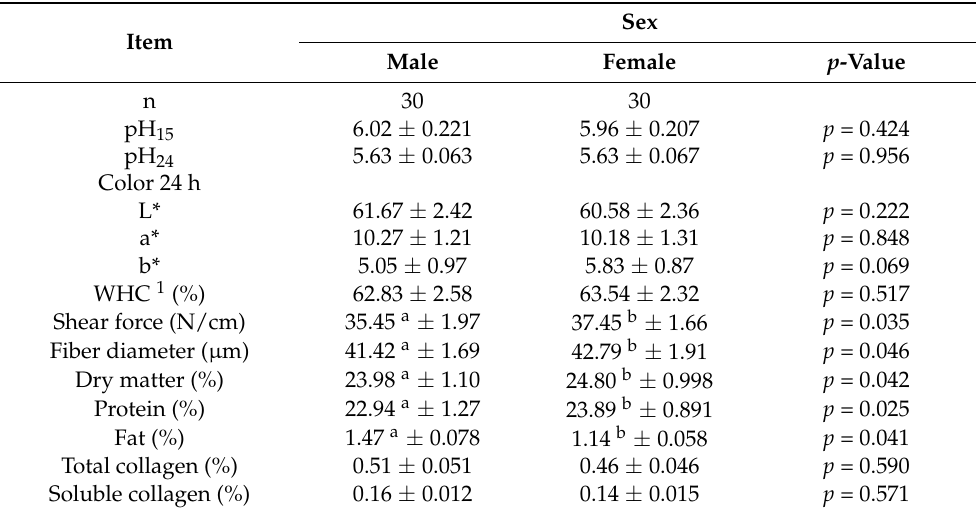
Table 3. Effects of sex on physicochemical traits and fiber diameter of the pectoral muscle of chickens reared in the organic system at 82 days (mean values ±